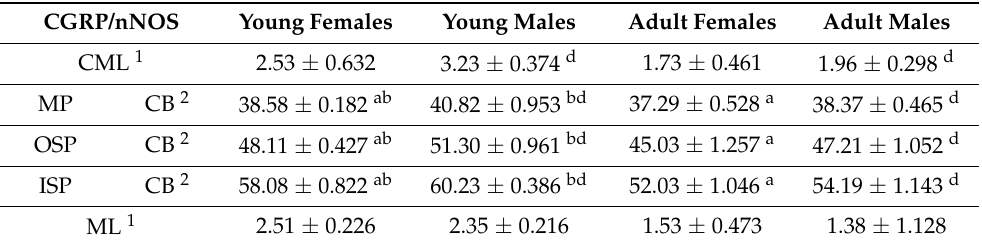
Table 5. The co-localization of CGRP with a neuronal isoform of nitric oxide synthase (nNOS) in the enteric nervous structures of the porcine descending colon under physiological conditions in young (10-week old) females and males and adult (6-8 months old) females and males. CGRP/nNOS Young Females Young Males Adult Females